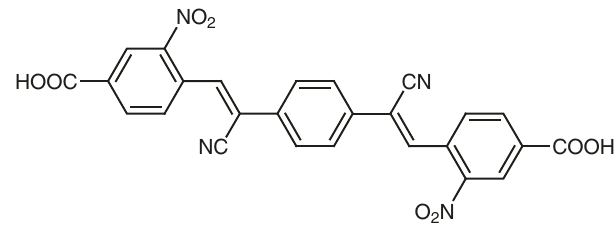
Fig. 2 Chemical structure of PV3 molecular wire